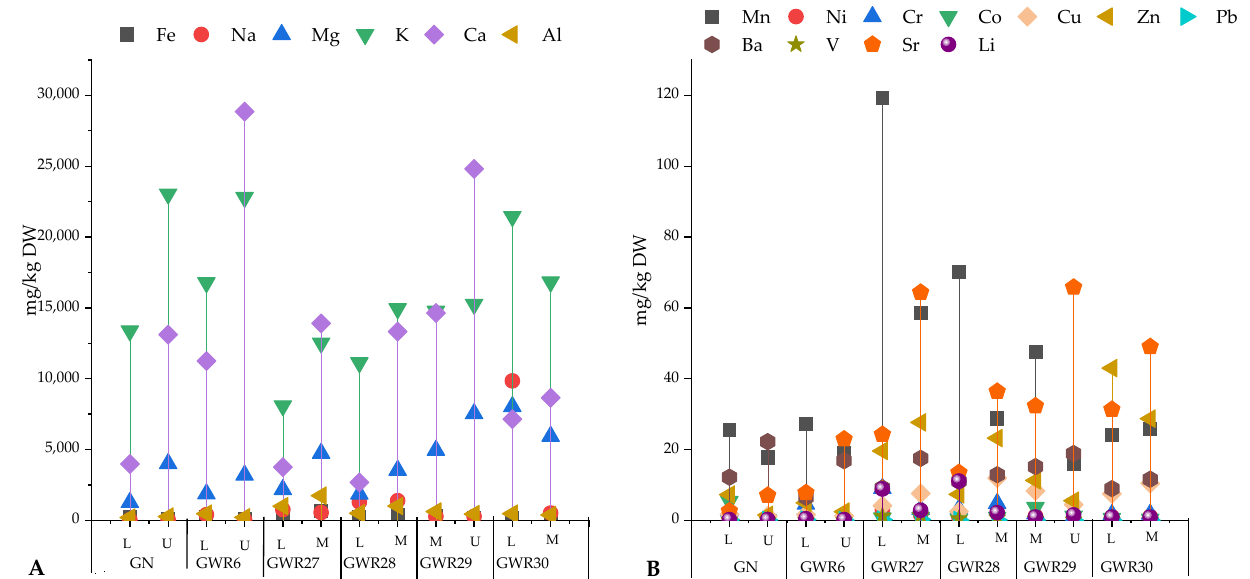
Figure 4. Macro ( A ) and microelement ( B ) content of plant samples ( Lolium sp.—L, Urtica sp.—U, and Mentha sp.—M) in Banat (GN, GWR6) and Dobrogea (GWR27, GWR28, GWR29, and GWR30) region.